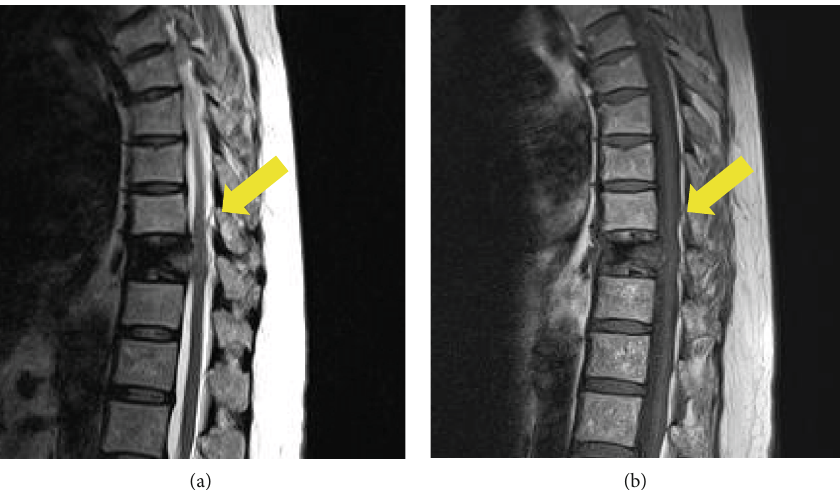
Figure 1: Sagittal views of thoracic magnetic resonance images on T2-weighted images (a) and T1-weighted images (b). T10 vertebral body demonstrated low intensity on the T2- and T1-weighted images and small epidural mass (yellow arrow) at the T9 dorsal side of the central canal was hyperintense on the T2-weighted images and was iso- to hyperintense on the T1-weighted images. These fi ndings indicate T10 vertebral fracture and epidural